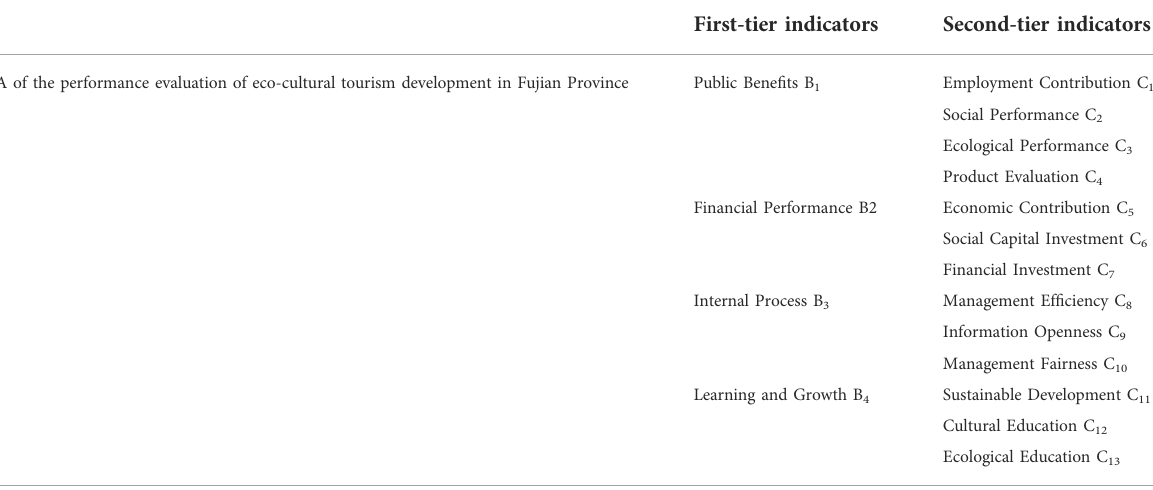
TABLE 1 Set of performance evaluation indicators of eco-cultural tourism development in fujian